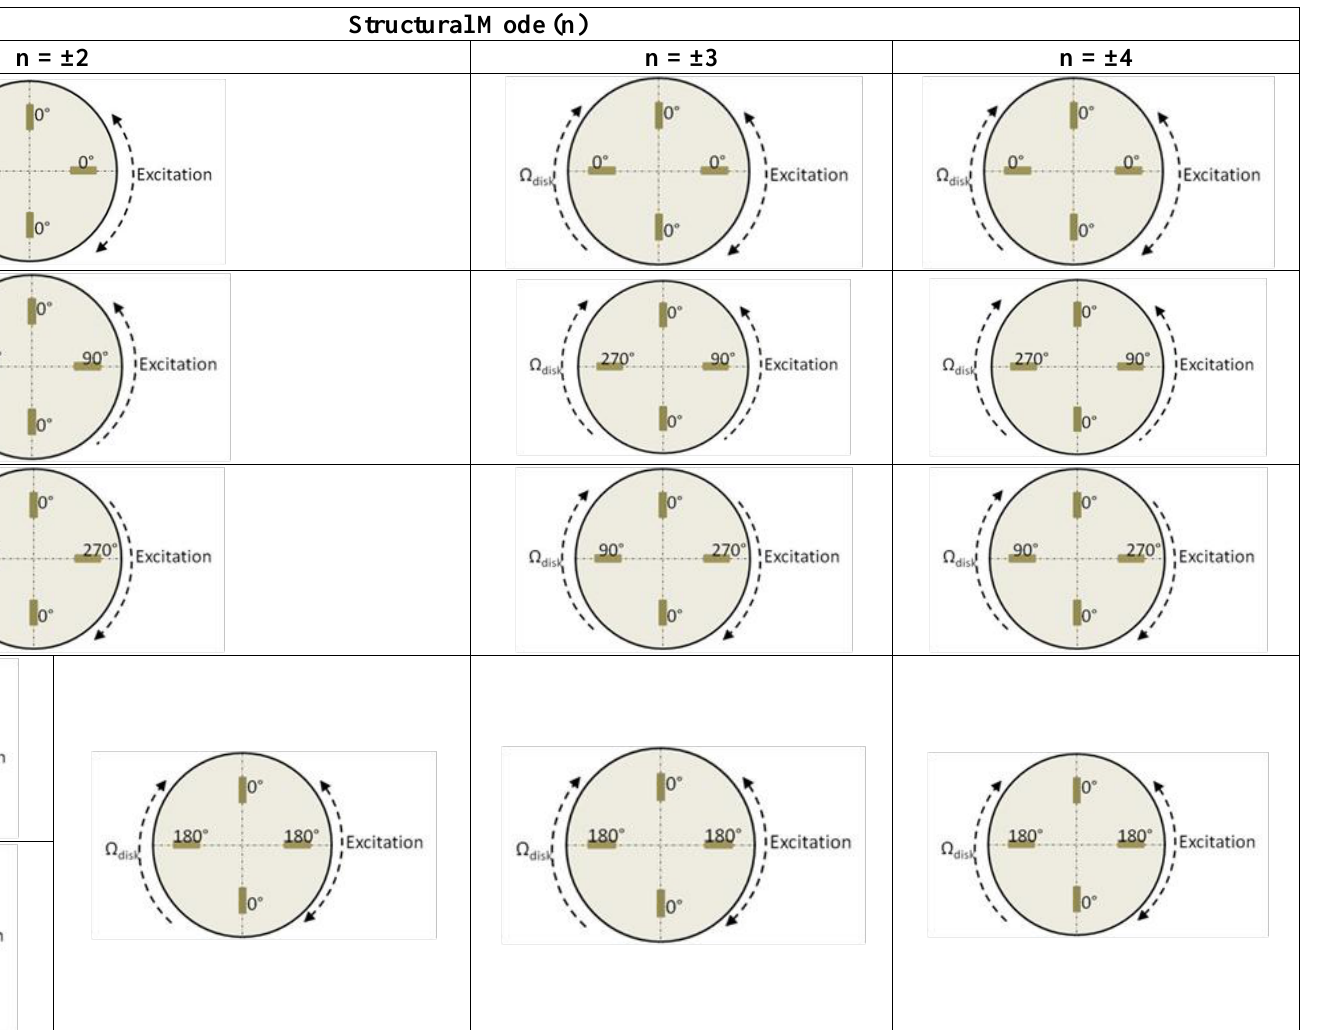
Figure 9. Excitation patterns created with the installed Piezoelectric